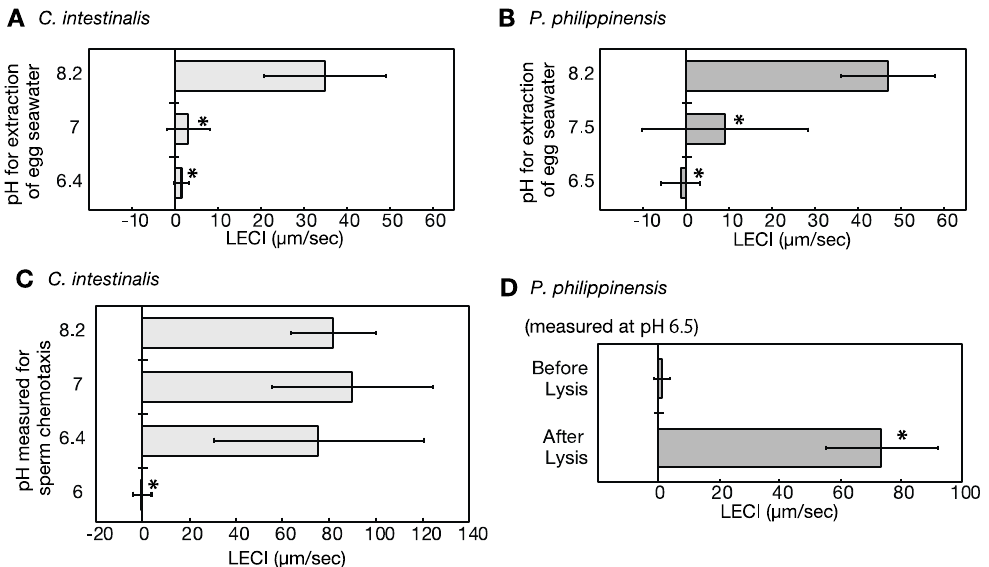
Figure 3. Effect of pH on sperm chemotaxis of the ascidians Ciona intestinalis and Phallusia philippinensis . ( A , B ) Effect of pH on sperm attracting ability of the eggs of C. intestinalis ( A ) and P. philippinensis ( B ). The egg-conditioned seawaters were prepared at a different pH, packed in capillary tips, and sperm movements in the vicinity were observed to calculate the chemotaxis index (LECI). Values are expressed as the mean ± standard deviation (SD) of three samples (30–36 sperm). Asterisks show the point of statistical significance against LECI at pH 8.2 ( p < 0.05, Dunnett’s test). ( C ) Effect of pH on chemotactic behavior of the sperm of C. intestinalis . The spermatozoa were pre-activated with 1 mM theophylline, and sperm movements around the capillary containing SAAF, the sperm attractant of C. intestinalis, were examined in each pH conditions. Values are expressed as the mean ± SD of ten samples (10–11 sperm). Asterisks show the point of statistical significance against LECI at pH 8.2 ( p < 0.05, Dunnett’s test). ( D ) Sperm attracting ability of intact and punctured eggs of the ascidian P. philippinensis . Values are expressed as the mean ± SD of four samples (31–41 sperm). Statistical significance is set at * p < 0.05 (Student’s t -test).